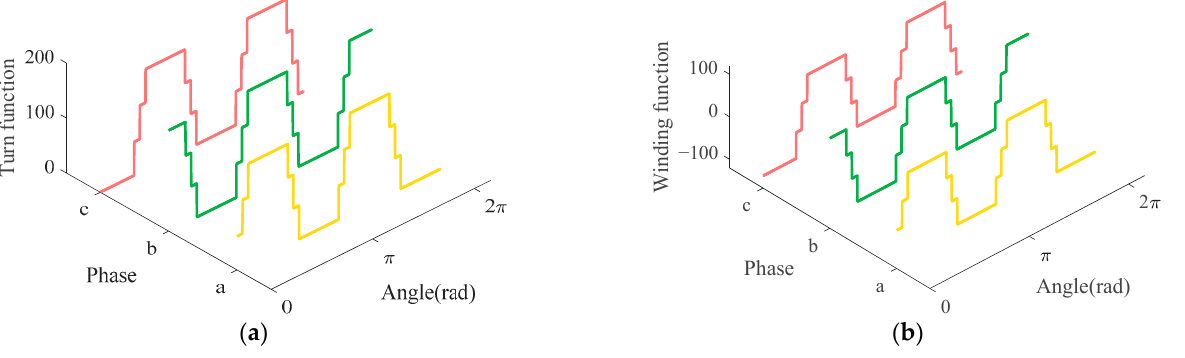
Figure 5. TFs and WFs of three-phase stator windings. ( a ) TFs; ( b ) WFs.